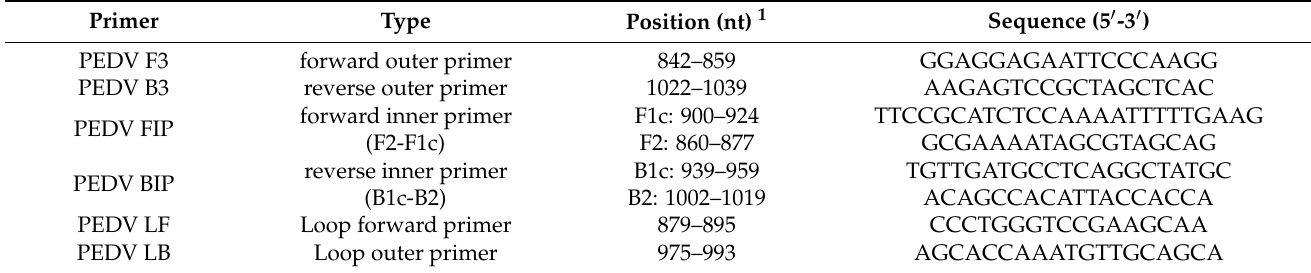
Table 1. Sequences of primers used for RT-LAMP and RT-PCR